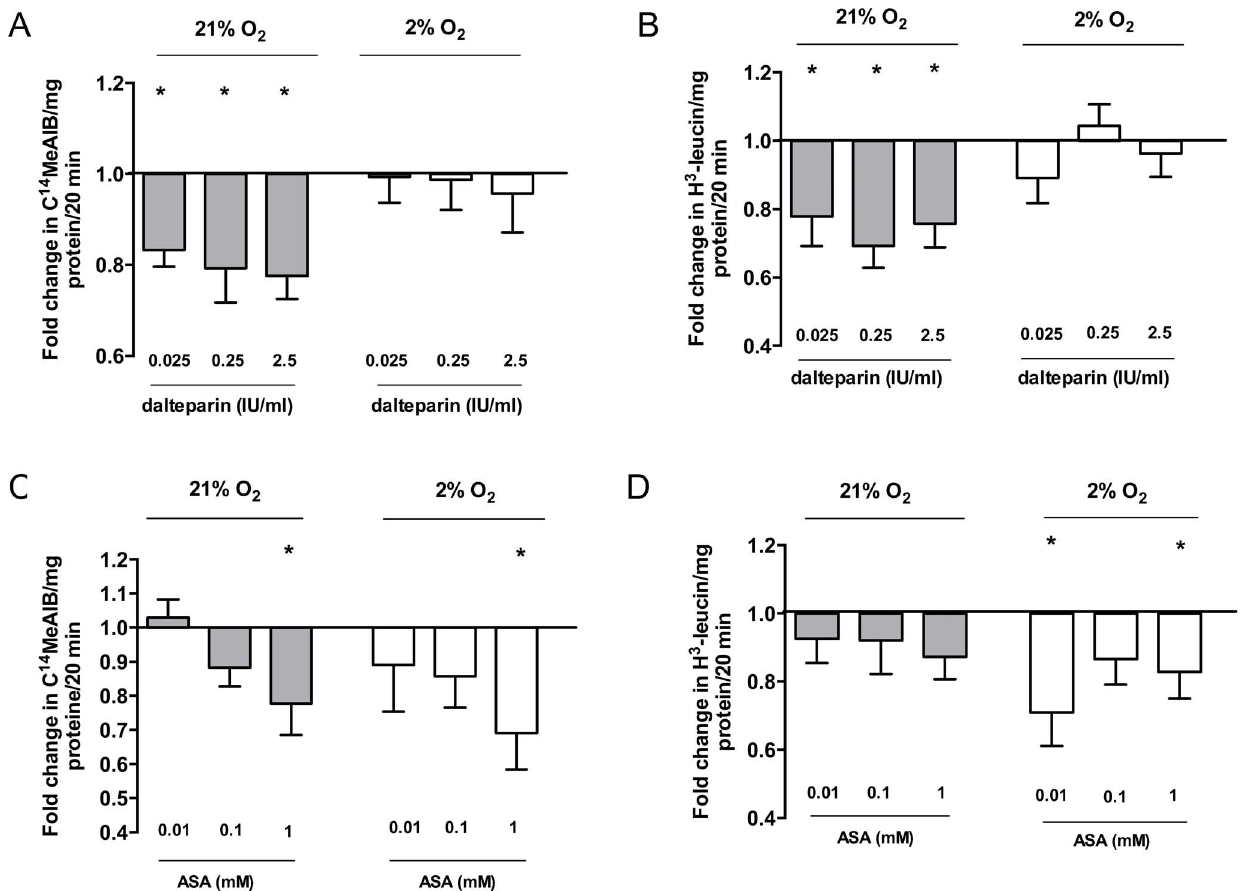
Figure 2. System A (A, C) and L (B, D) amino acid transporter activities in placental villous explants after 2 h of incubation with dalteparin (0.025 IU/ml, 0.25 IU/ml, 2.5 IU/ml) or with ASA (0.01 mM, 0.1 mM, 1 mM) at 21% and 2% O 2 . Values are relative means 6 SEM. *p , 0.05 compared to untreated control (set to 1).